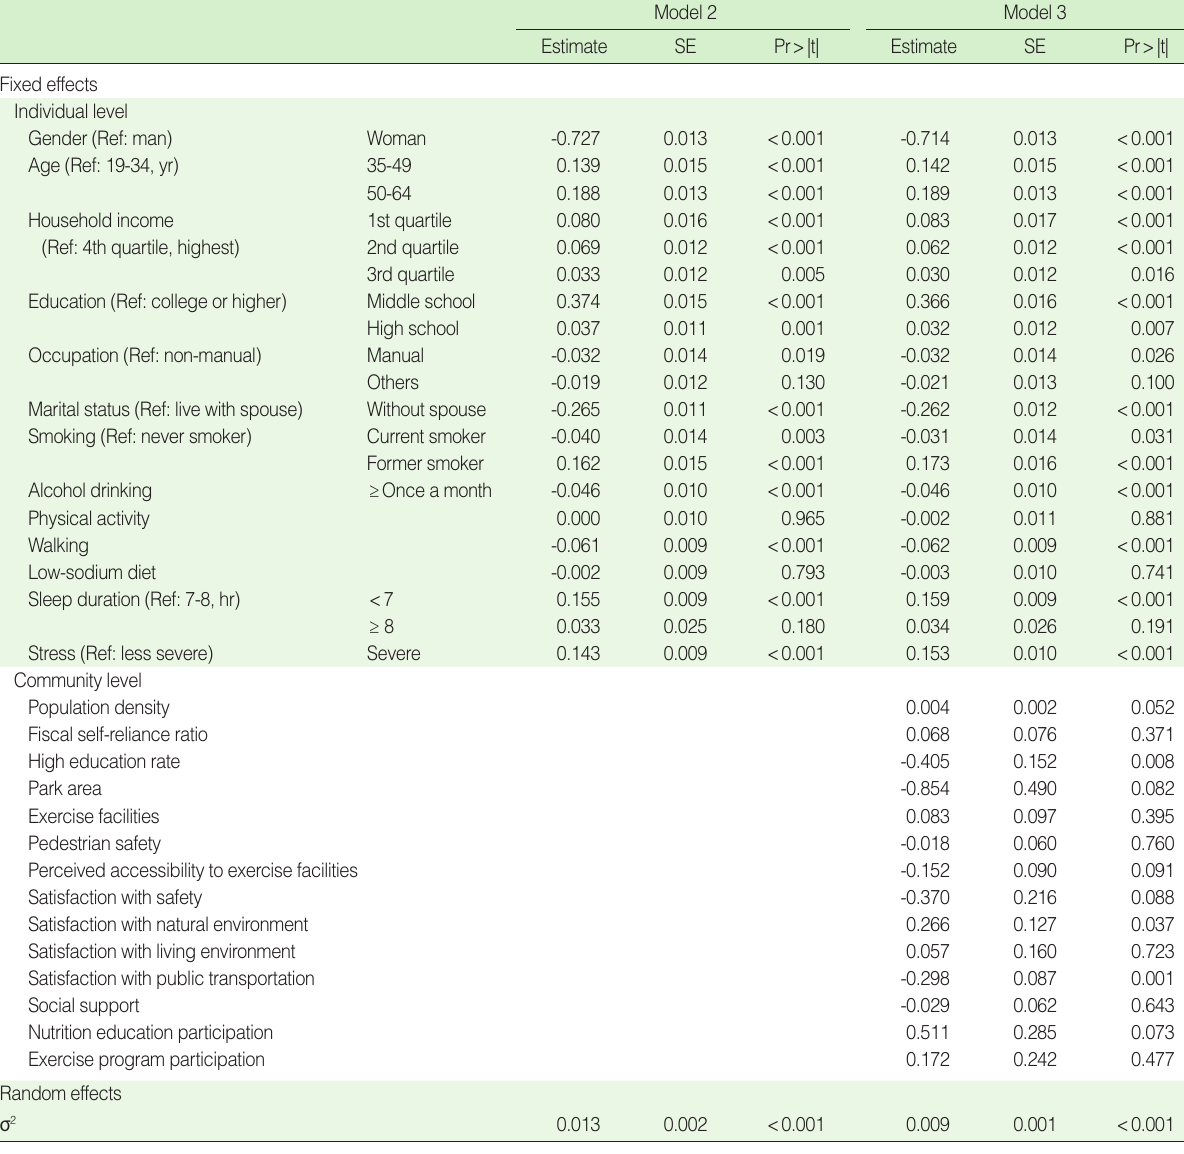
Table 2. Factors affecting obesity based on multilevel